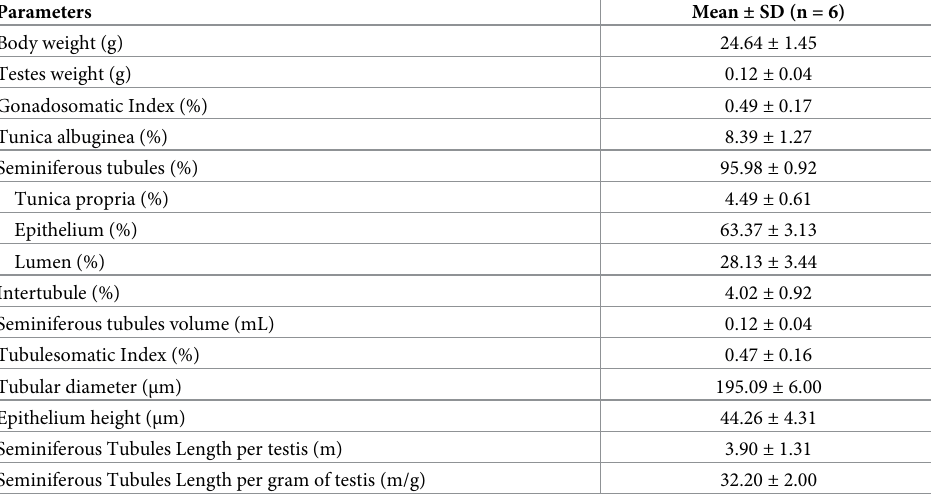
Table 1. Biometry and morphometry of the testicular components of Diphylla ecaudata . The data are reported as mean ± standard deviation (SD) of the mean.